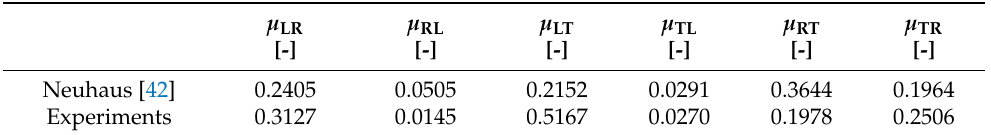
Table 5. Comparison of Poisson’s ratios of spruce according to Neuhaus [42] for MC = 4% and own experiments on beech LVL